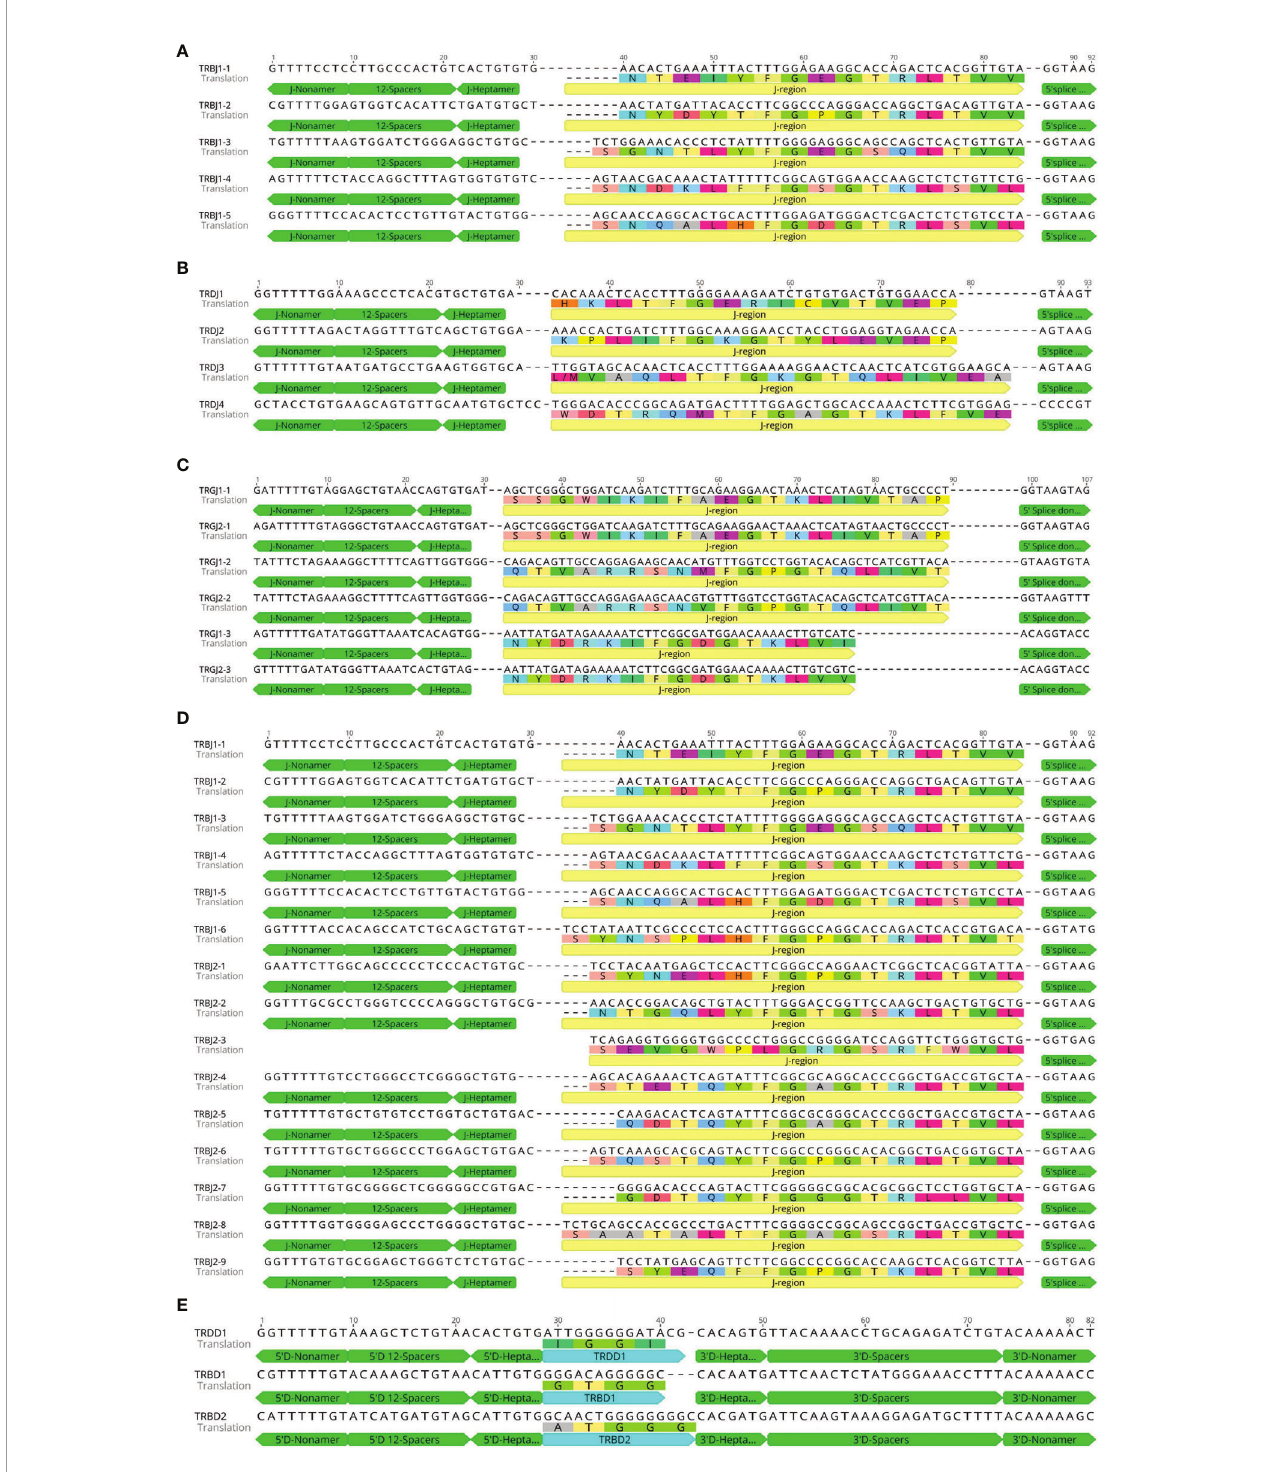
FIGURE 7 | Nucleotide and deduced amino acid sequences of the bat TRAJ (A) , TRDJ (B) , TRGJ (C) , TRBJ (D) , TRBD, and TRBD (E) genes. The heptamer, nonamer, and splice donor are labeled. The numbering adopted for the gene classi fi cation is reported on the left of each